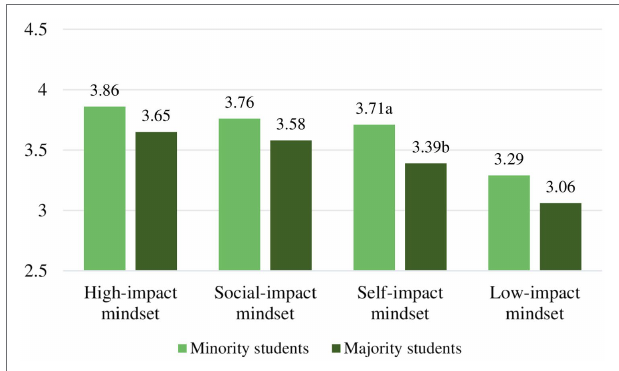
FIGURE 5 | Ethnic group mean levels in study engagement. (Different letters denote significant differences between subgroups within